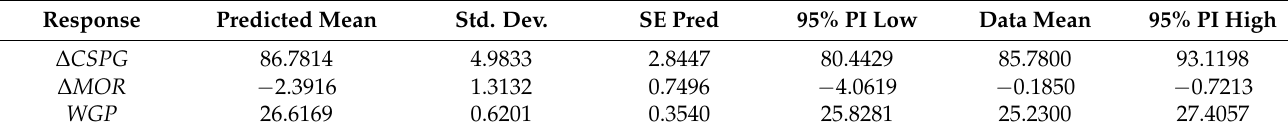
Table 5. Statistical parameters of confirmatory test results.